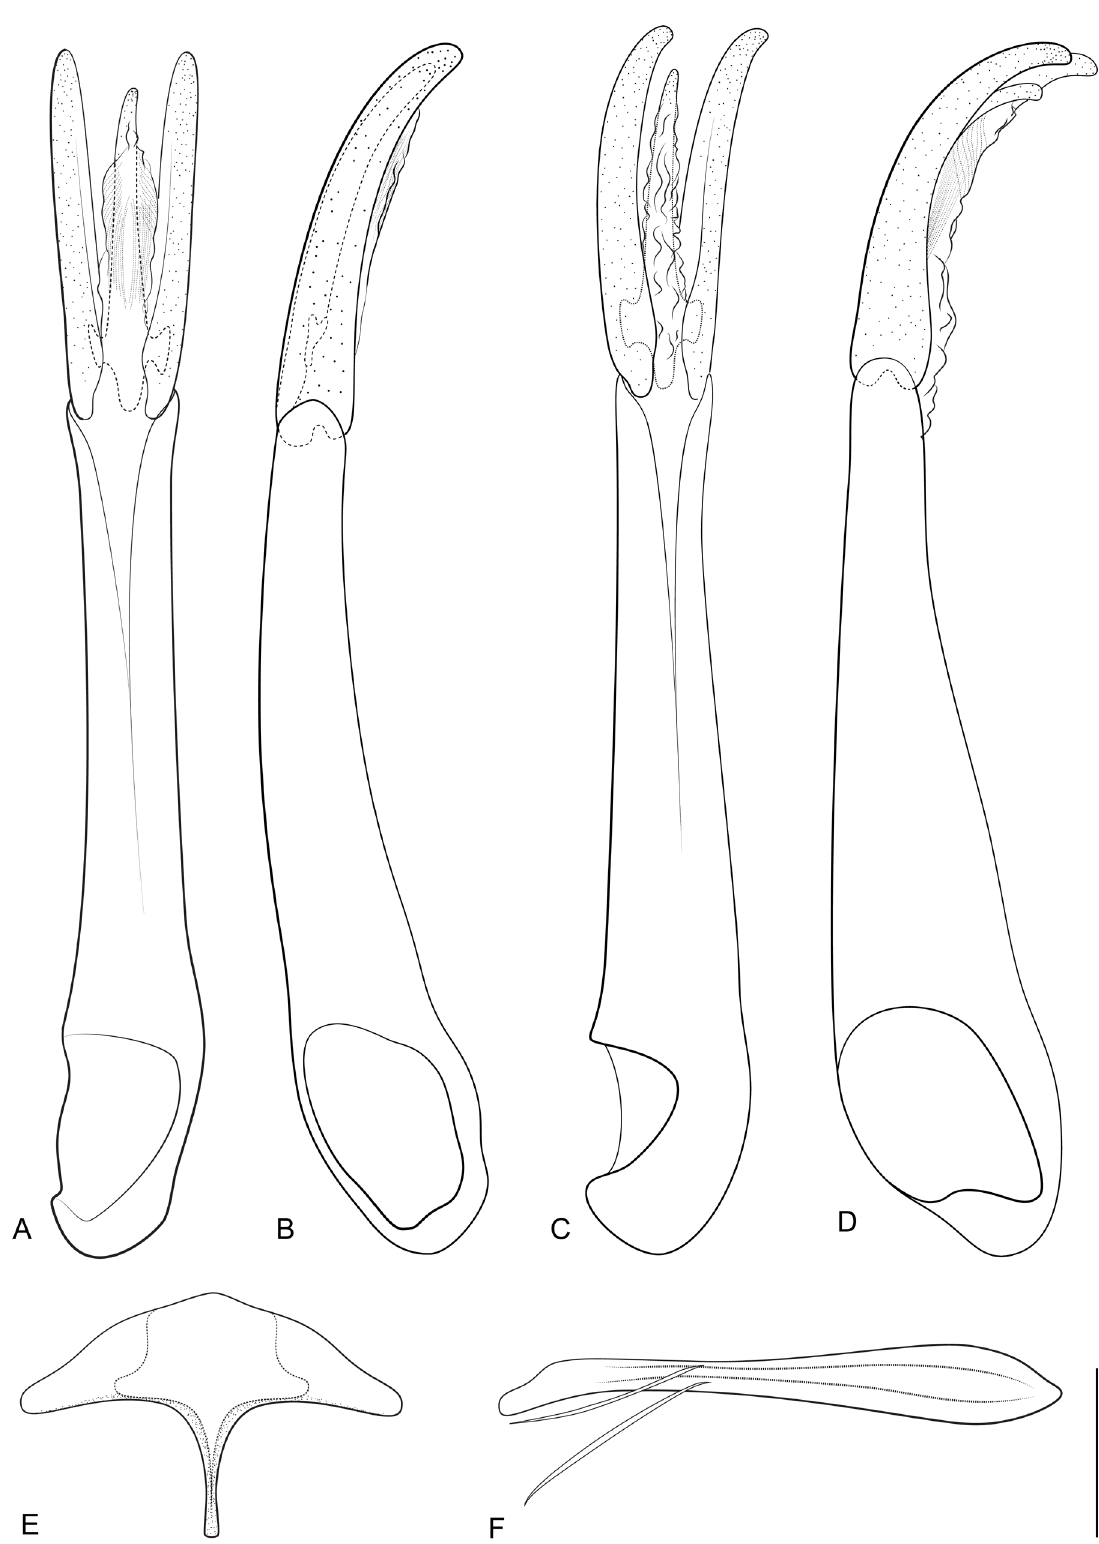
Fig. 8. Male terminalia. A–B, E–F . Elmomorphus brevicornis Sharp, 1888 (JKCB). A . Aedeagus, ventral aspect. B . Ibidem, lateral aspect. C–D . Elmomorphus amamiensis Nomura, 1959 (JKCB). C . Aedeagus, ventral aspect. D . Ibidem, lateral aspect. E . Sternite VIII. F . Sternite IX. Scale bar = 0.1